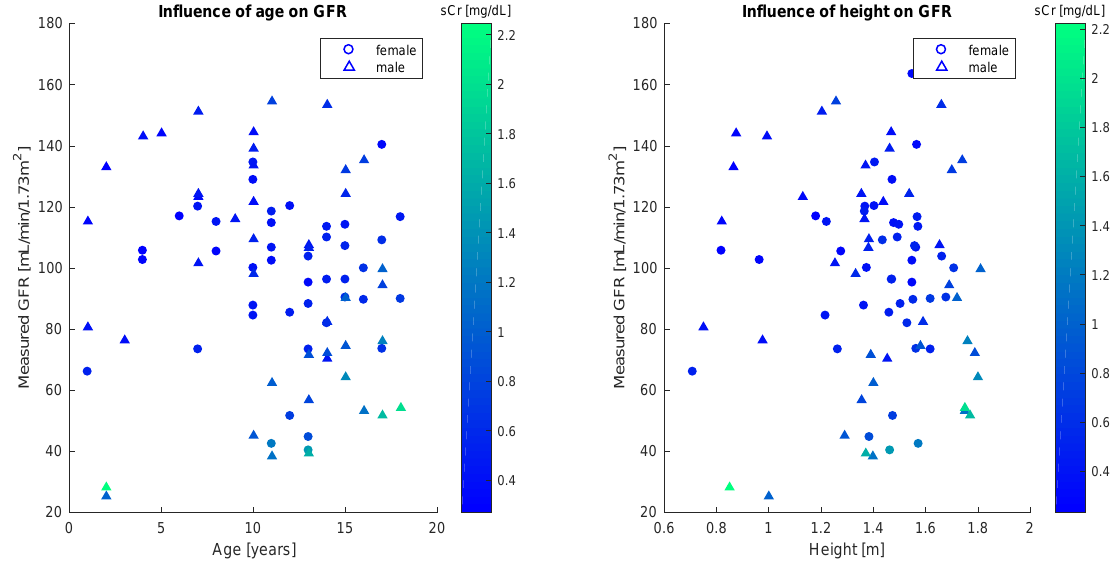
Figure 3. Scatter plots of the glomerular filtration rate versus pediatric patients age or height suggest weak correlation. Serum creatinine concentration refers to the IMDS-traceable values.